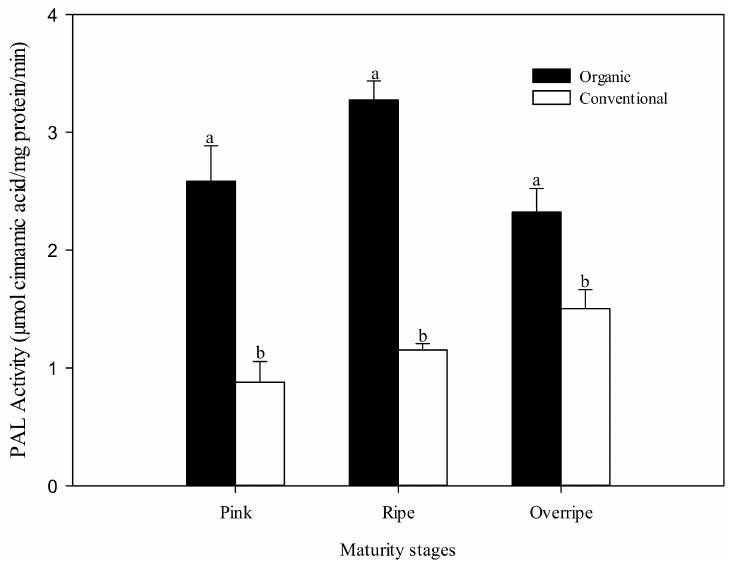
Figure 3. The activity of phenylalanine ammonium-lyase (PAL) at three stages of maturity with two fertilization procedures. The results are represented as means ± standard deviation. Different letters between maturity stages indicate statistical difference ( p ≤